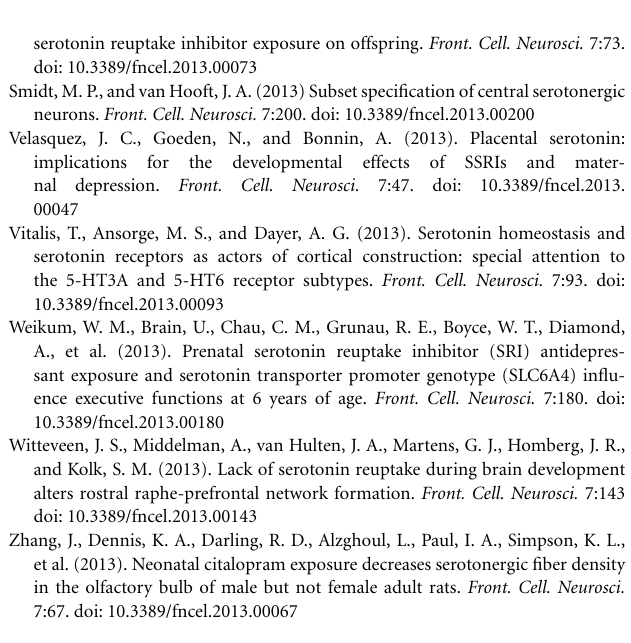
FIGURE 1 | The relationship between genetic and pharmacological manipulations affecting the serotonin system showing similar effects on brain wiring and behaviour (from Kinast et al., 2013), see